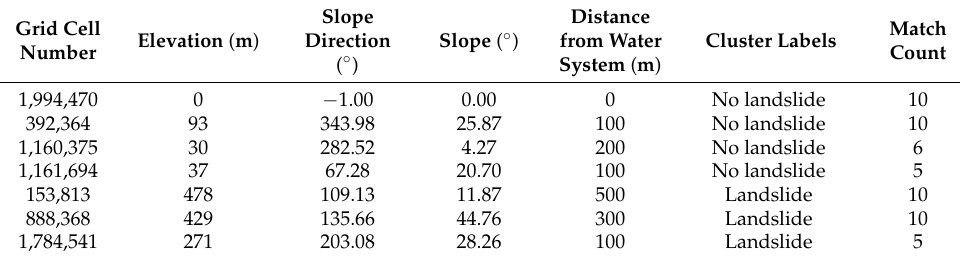
Table 1. Highly trusted data